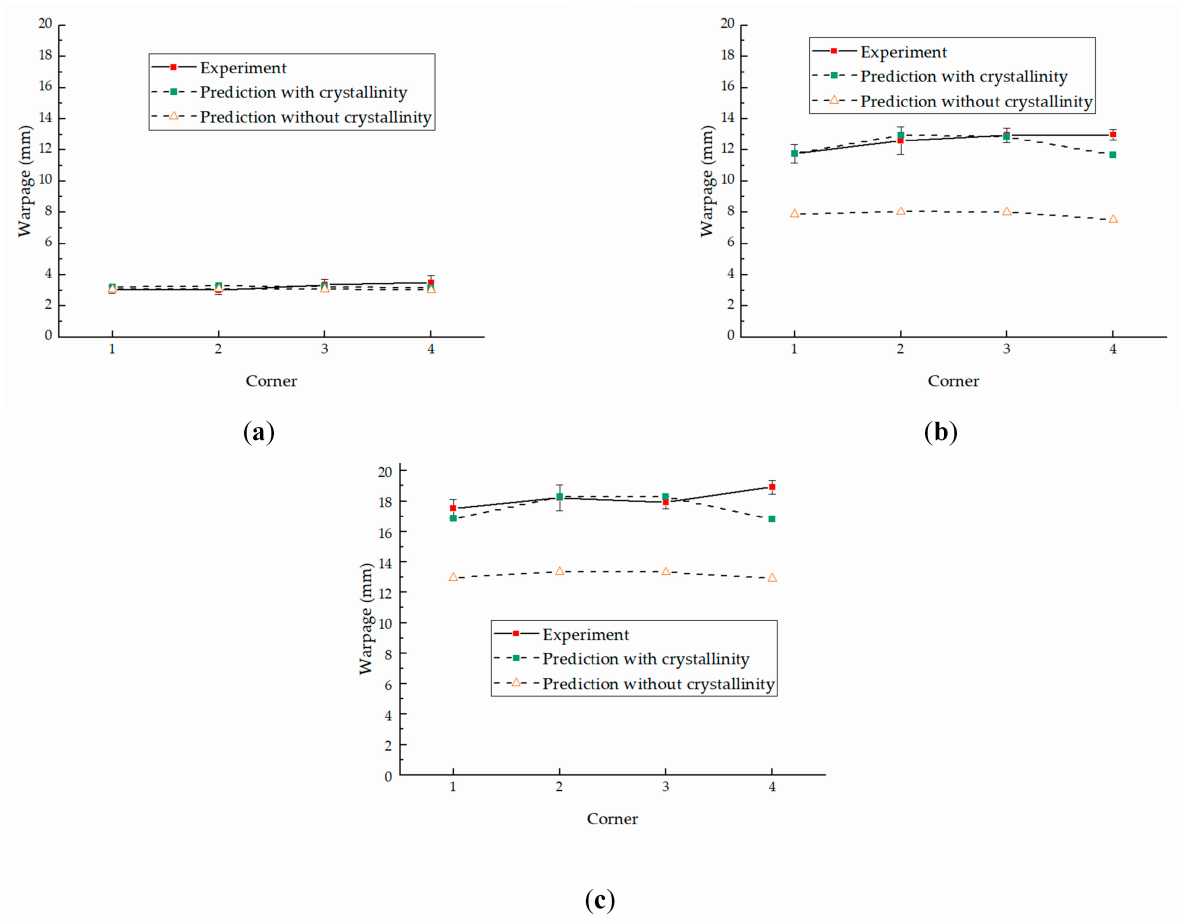
Figure 10. The maximum values of warpages of experiment and prediction: ( a ) CIM, ( b ) RHCM60, ( c ) RHCM90. The predicted warpage without crystallinity deviates more from the experimental warpage in the parts molded by the RHCM process than that with crystallinity. The average errors of warpage prediction of CIM are 0.23 and 0.22 mm with and without crystallinity, respectively, with a difference of 4.5%. The small difference is mainly due to the symmetrical distribution of thickness and crystallinity. However, the difference is much greater between the warpage prediction with and without crystallinity for parts molded by the RHCM process. The average errors of the warpage prediction of RHCM60 are 0.44 and 4.71 mm with and without crystallinity, respectively, with a difference of 970.5%. Additionally, the average errors of warpage prediction of RHCM90 are 0.81 and 5.00 mm, with a difference of 517.3%. They are mainly introduced by the asymmetrical distribution of thickness and crystallinity, as discussed